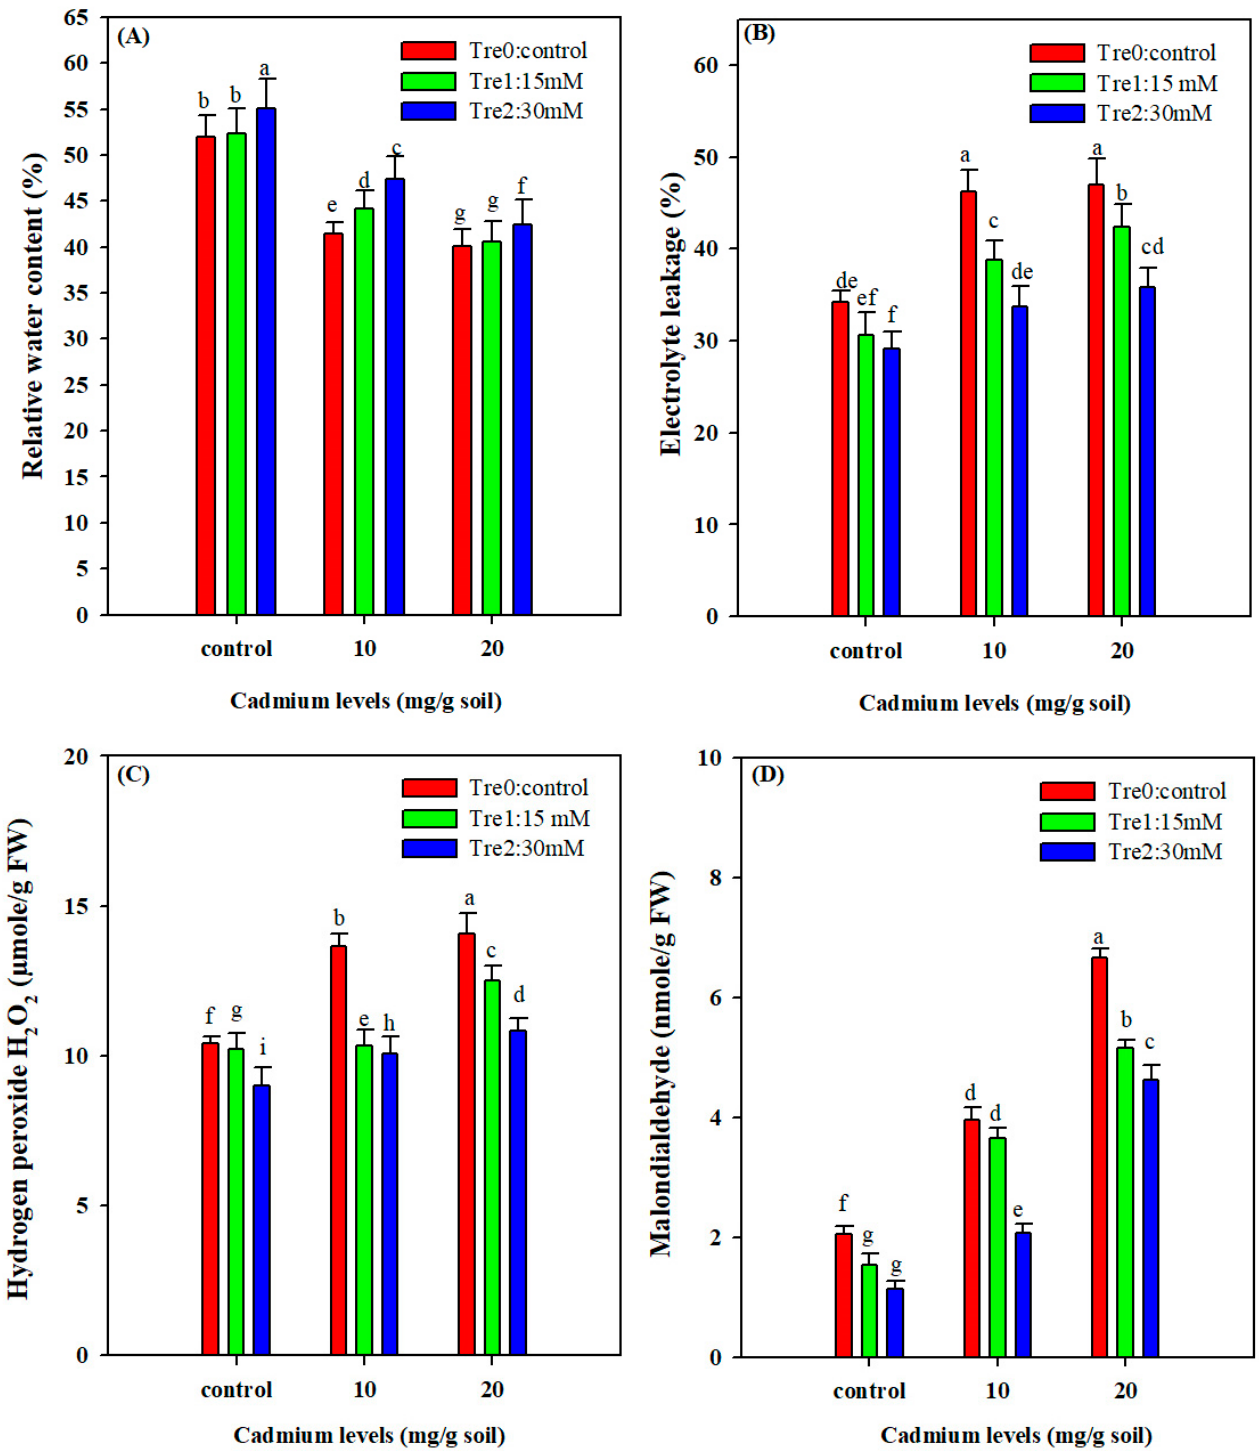
Figure 2. Effect of foliar application of Tre on RWC ( A ); electrolyte leakage ( B ); H 2 O 2 ( C ); and MDA ( D ) contents of mung bean grown under Cd stress. The values are the means of three replicates with ± S.E and the different letters above the bars under the same treatment show the significant differences at p < 0.05.